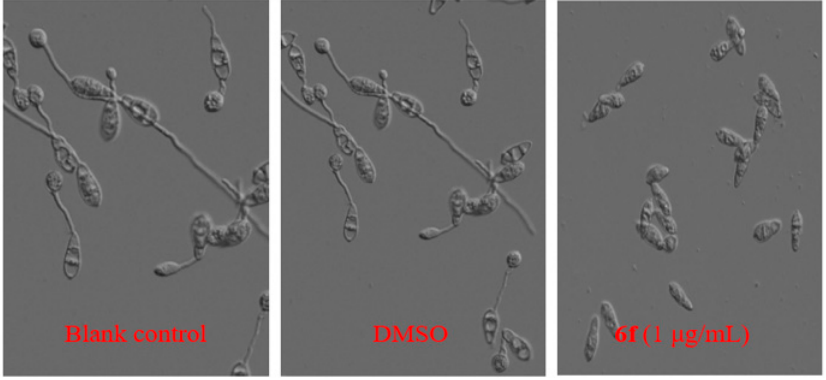
Figure 4. The effect of 6f on the conidium germination rate of M. oryzae .